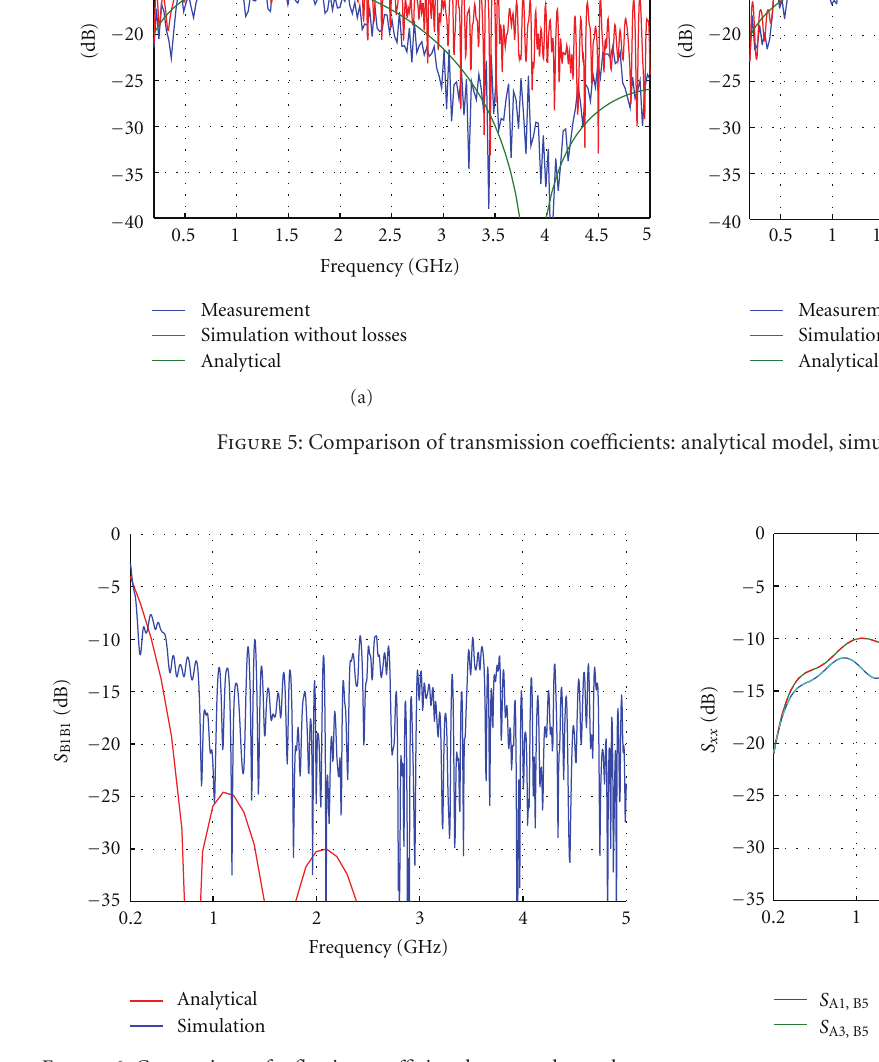
Figure 7: Amplitude of transmission after gating the main pulse, Input at